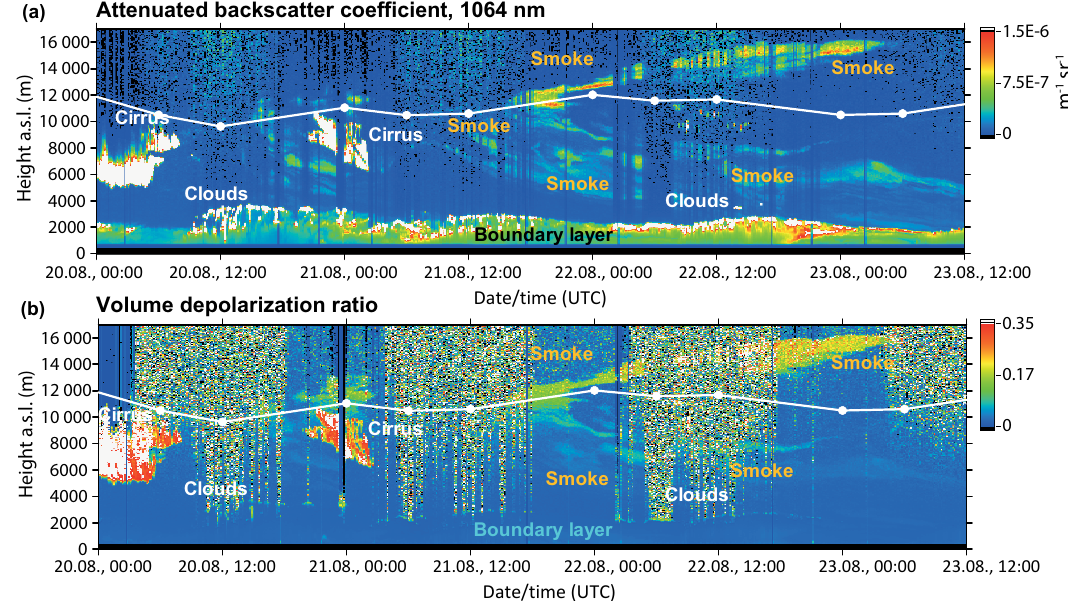
Figure 2. Canadian wildfire smoke layers in the troposphere and stratosphere over Kosetice, Czech Republic, observed with lidar from 20 to 23 August 2017. The uncalibrated attenuated backscatter coefficient (range-corrected signal) at 1064nm (a) and the volume linear depolarization ratio at 532nm (b) are shown as a function of height above sea level (a.s.l.). Particle extinction coefficients at 532nm ranged from 250 to 500Mm − 1 in the stratospheric layer at a height of 12 to 16km (21 August, 21:00UTC to 23 August, 05:00UTC). The tropopause height according to the Prague radiosonde, launched daily at 00:00, 06:00, and 12:00UTC (see full circles), is given by white